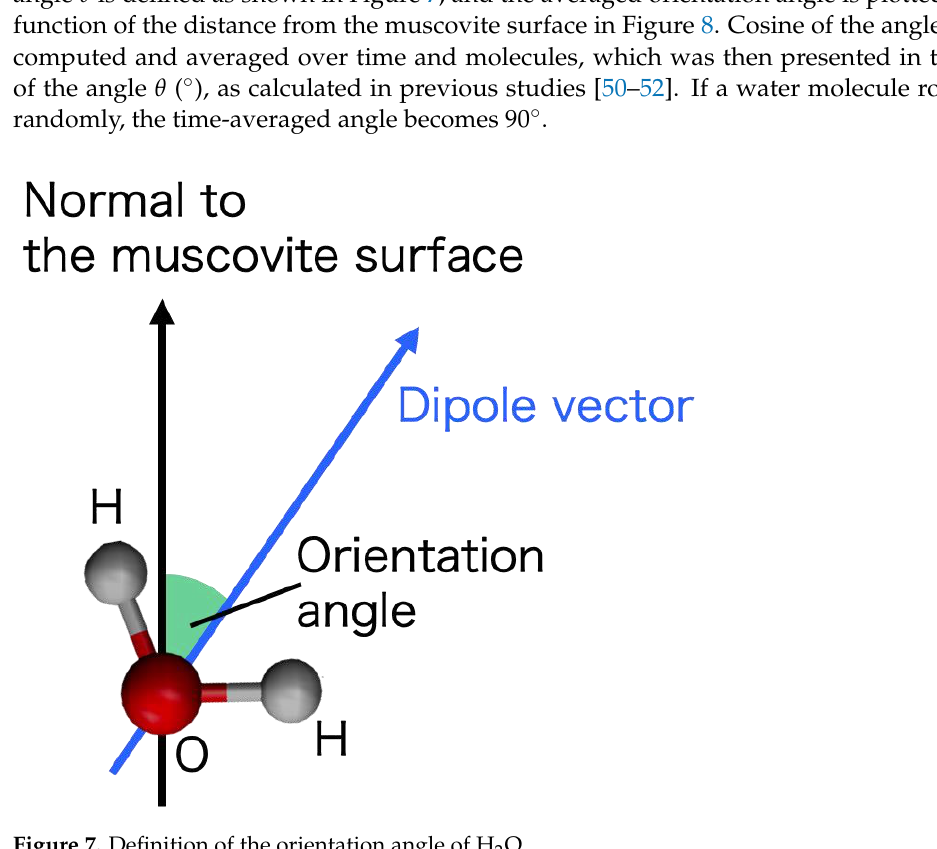
Figure 7. Definition of the orientation angle of H 2 O. As shown in the snapshot in Figure 5a, hydrogen atoms of H 2 O molecules adsorb directly on the muscovite, which results in the high orientation angle ( θ ~150 ◦ ) in the first layer (0.1 nm < d < 0.2 nm) in Figure